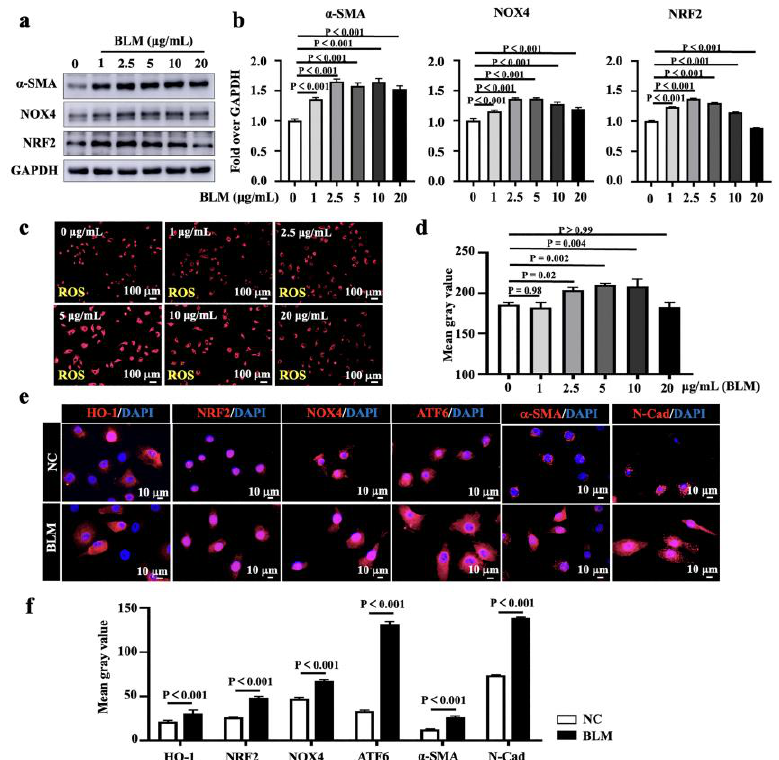
Figure 2. BLM induces NOX4-mediated oxidative stress in A549 lung epithelial cells. ( a ) Representa- tive images of immunoblotting blots revealed an increased expression of α -SMA, NOX4 and NRF2 in A549 cells exposed to indicated concentrations of BLM (1.0, 2.5, 5.0, 10.0, and 20.0 µ g/mL) for 48